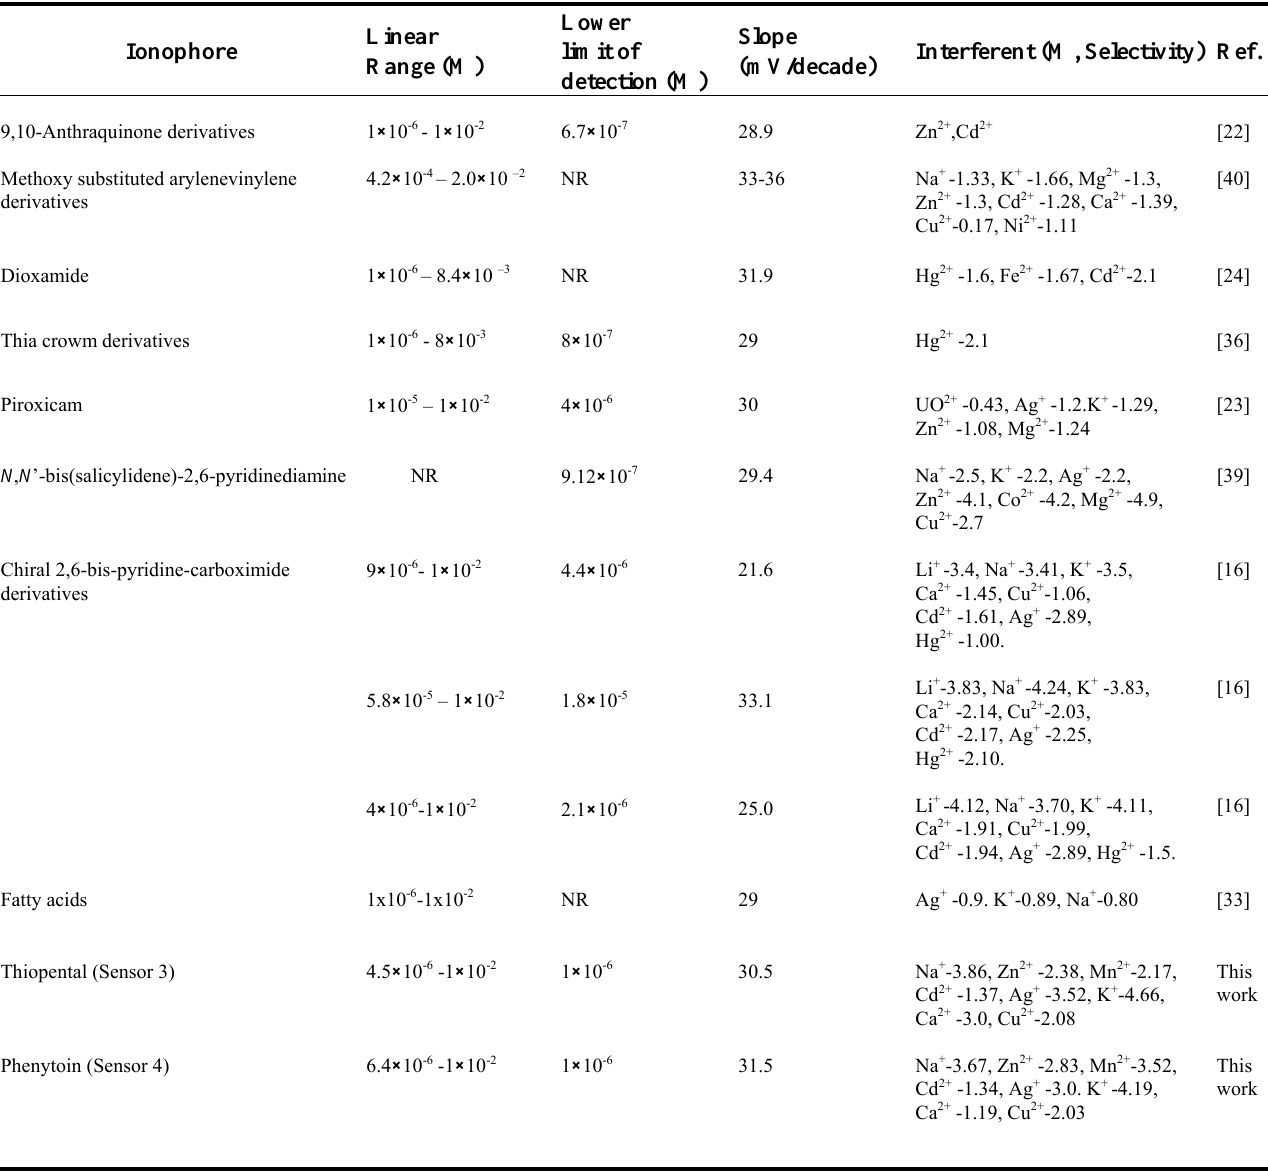
Table 4. General performance characteristics of some potentiometric lead membrane